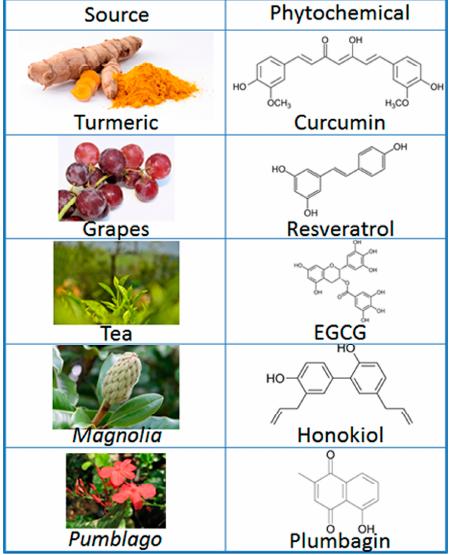
Figure 1. Phytochemicals and their sources. EGCG: Epigallocatechin gallate.